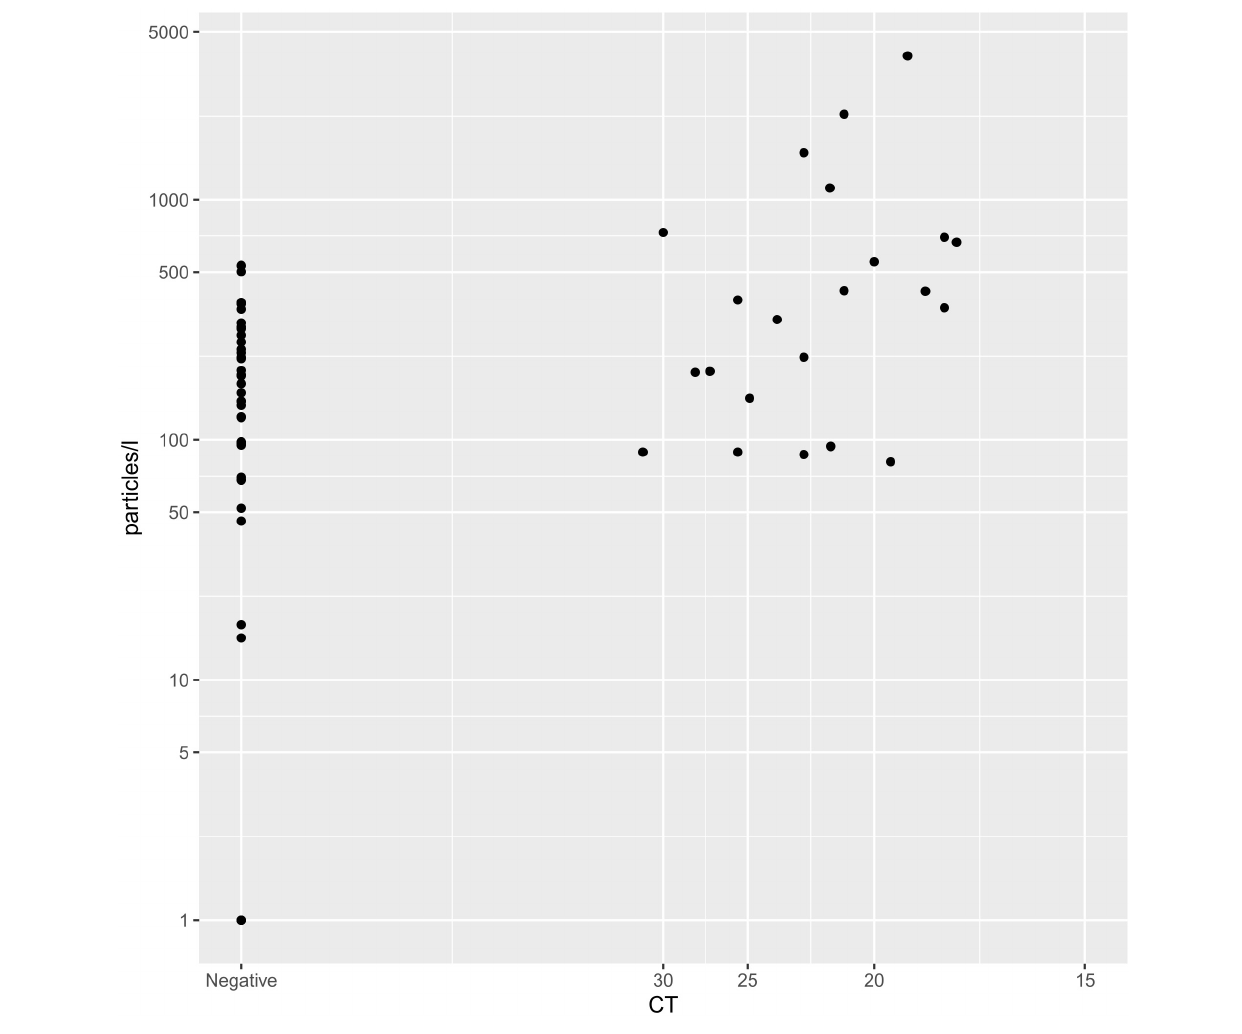
FIGURE 2 | Spearman correlation of CT-value and exhaled particle count. Displaying the correlation between Ct-value (x-axis) and exhaled particles